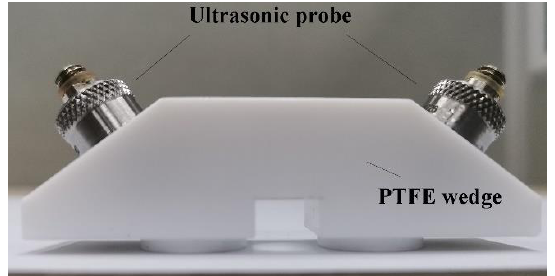
Figure 14. Polytetrafluoroethylene (PTFE) wedge and an ultrasonic probe.